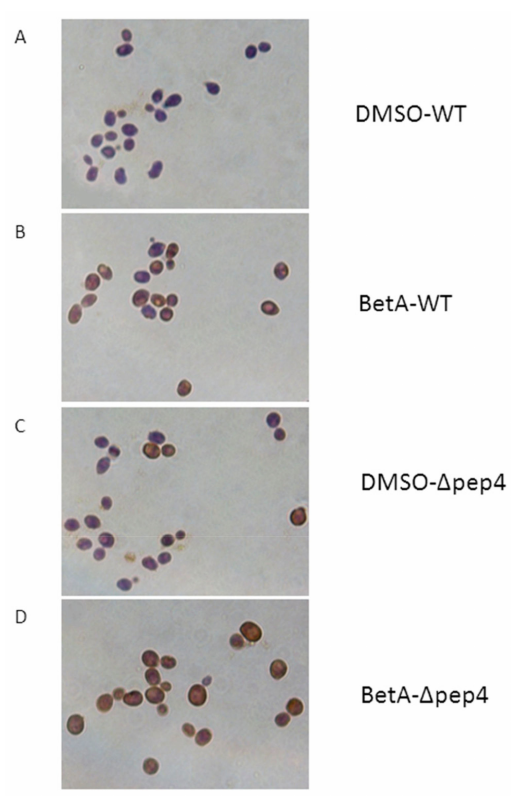
Figure 4. TUNEL-stained S. cerevisiae nuclei. 1 × 10 7 cells were incubated with 20 µ g / mL BetA for 4 h. Thereafter, yeast cells were stained with TUNEL. TUNEL-positive cells showed brown, while TUNEL-negative cells showed blue, magnification, 1000 × . ( A ) The TUNEL -stained DMSO-WT group, ( B ) The TUNEL -stained BetA-WT group, ( C ) The TUNEL-stained DMSO- ∆ pep4 group, ( D ) The TUNEL -stained BetA- ∆ pep4